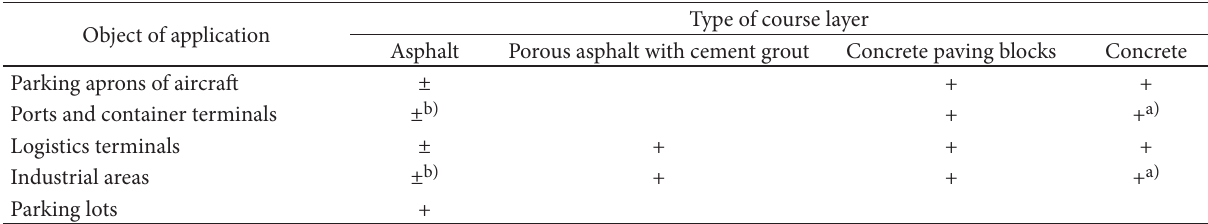
table 3. Recommendable and alternative solutions of course layer of pavement structure affected by static and impact